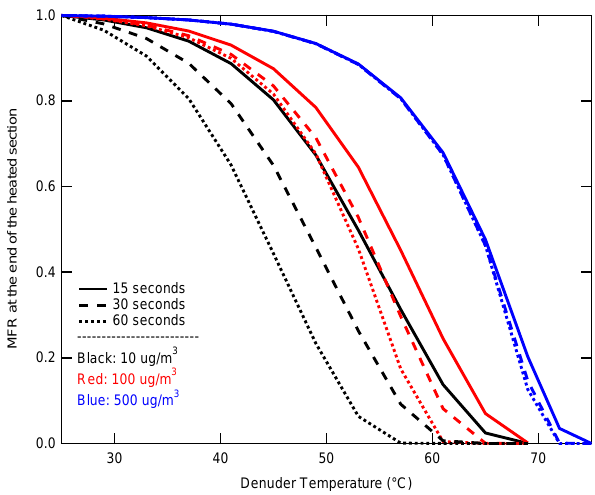
Fig. 7. The calculated mass fraction remaining at the end of the heated section (MFR h ) is shown as a function of T d for a single compound aerosol with C sat =1µg/m 3 ( 1H vap =120kJ/mol, d p =200nm) for different C OA values and different t res (see legend for specific